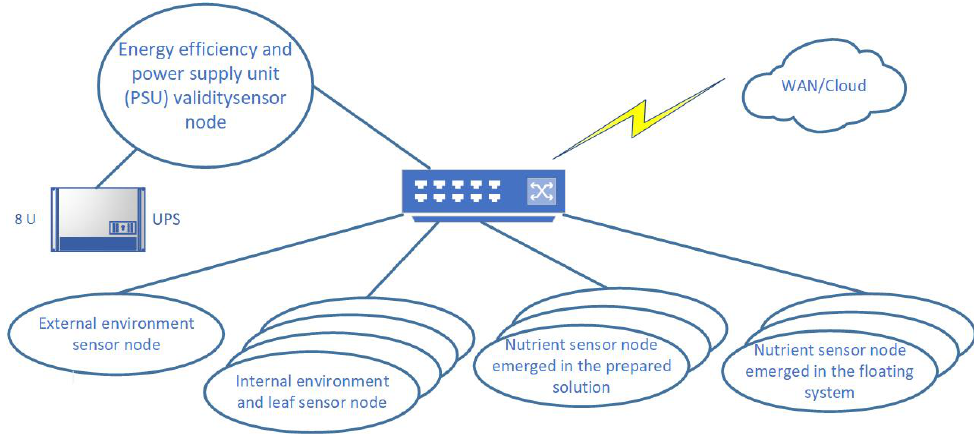
Figure 1. System design and physical architecture scheme. The image describes the organization of major greenhouse nodes with short descriptions. All nodes are interconnected through the local area network and communicate with cloud via the wide area